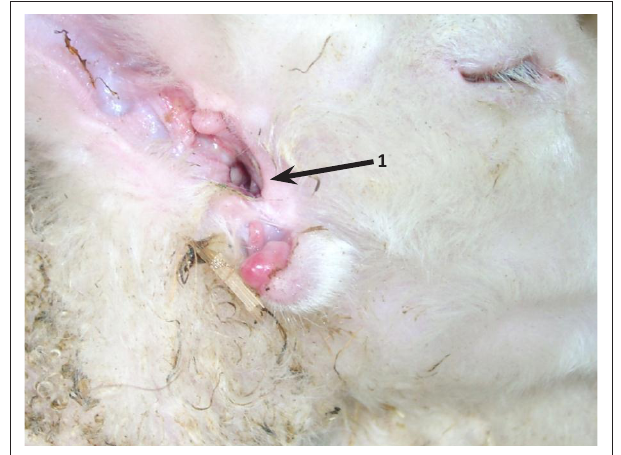
Figure 3 FIGURE 4: Lamb 1 with a less severe oro-auricular fistula in the right ear. Figure 5